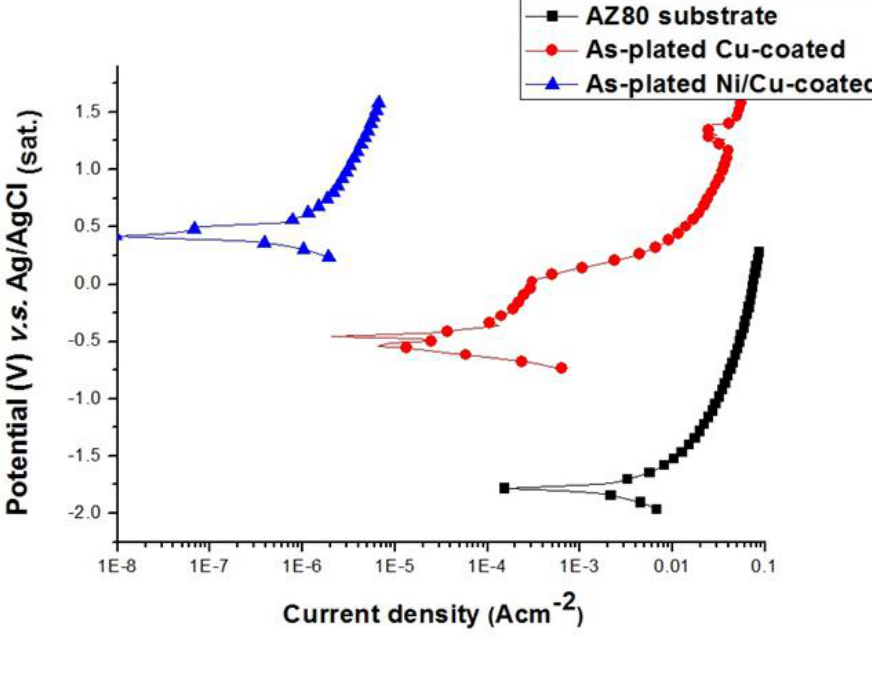
Figure 12. Anodic polarisation curves of Ni/Cu-, Cu-coated and uncoated AZ80 specimens with a U-shaped surface at a rotation speed of 1000